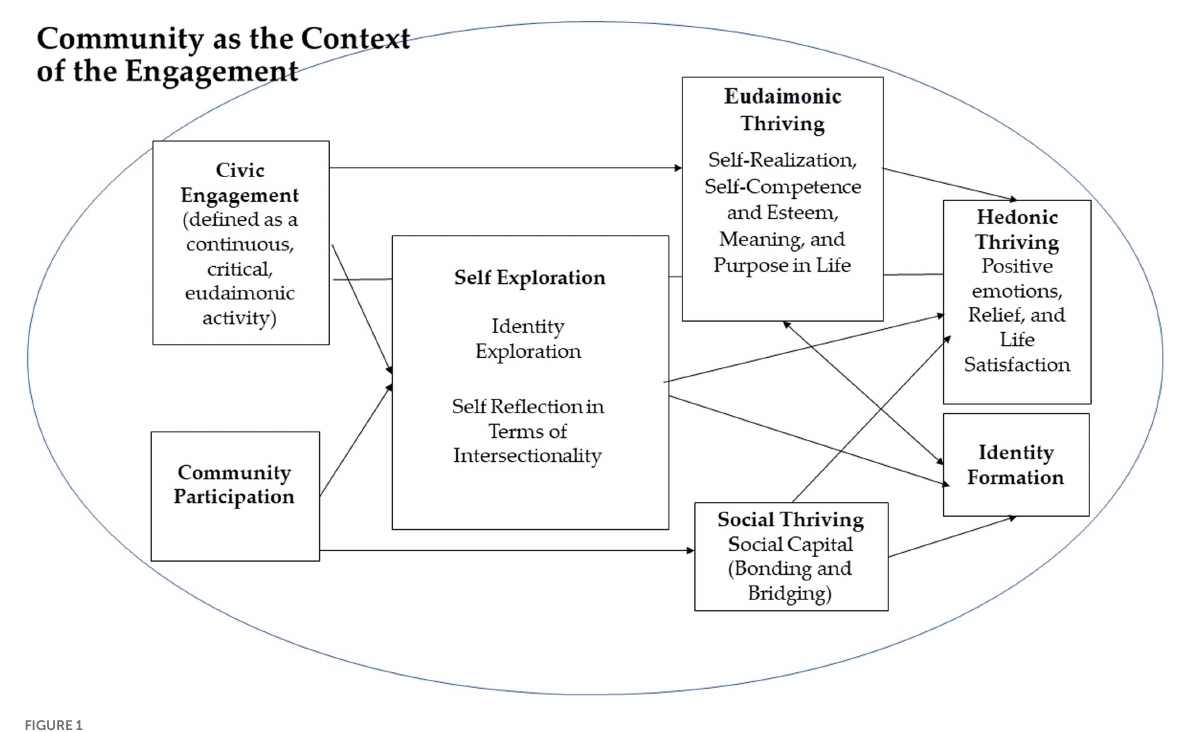
FIGURE 1 The civic engagement community participation thriving model